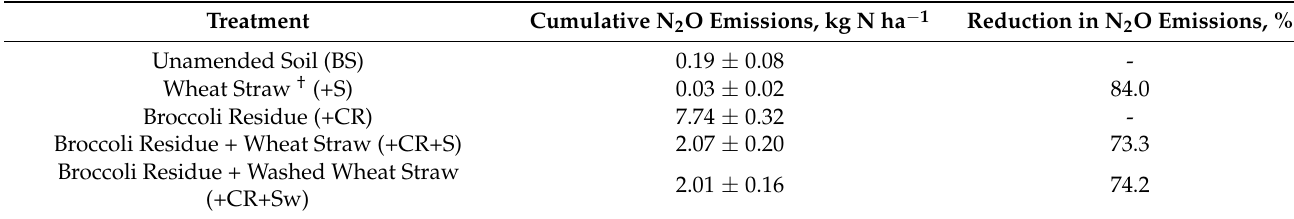
Figure 2. Cumulative N 2 O emissions (mean ± SE; n = 4) from soil microcosms with different treatments: BS = unamended or control, +S = wheat straw, +CR = broccoli residue, +CR+S = broccoli residue and wheat straw, +CR+Sw = broccoli residue and washed wheat straw. Means with different letters across treatments are significantly different at p < 0.05. Table 2. Cumulative N 2 O emissions and calculated immobilization potential of wheat straw used in the microcosm throughout the experimental period.